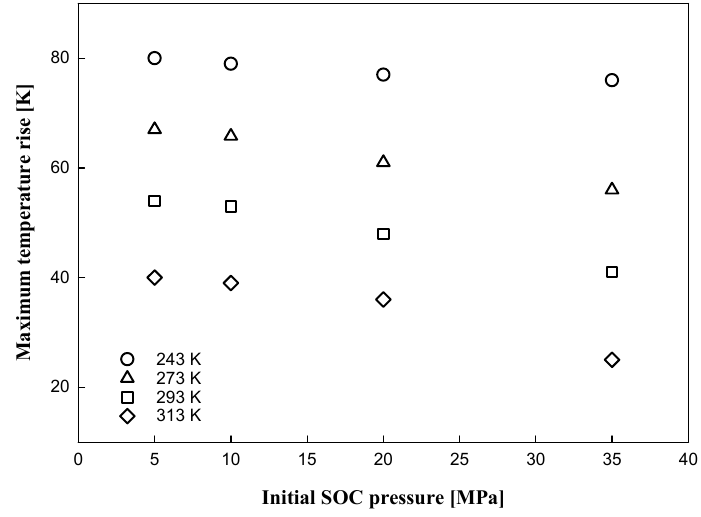
Figure 9. Maximum temperature rise with initial SOC pressure condition.